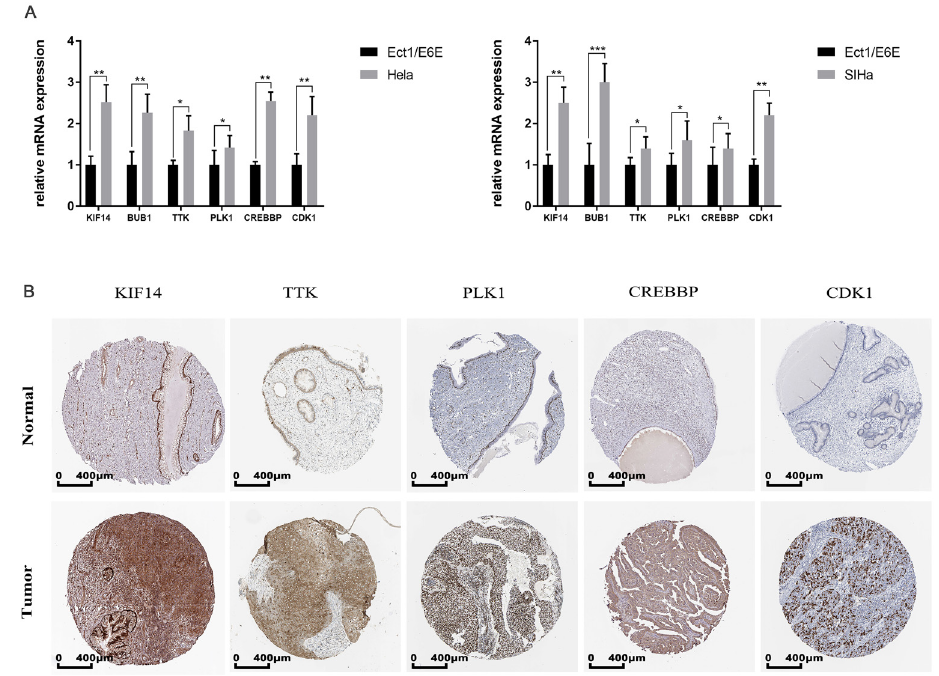
Figure 7. Kinesin family member 14 (KIF14) expression and the indexes of cell cycle signaling pathways. A , RT-PCR analysis results are shown of KIF14 and the indexes (BUB1, TTK, PLK1, CREBBP, and CDK1) of the cell cycle signaling pathways in human cervical cancer cells (HeLa and SIHa) and a normal cervical epithelial cell line (Ect1/E6E). B , The HPA database was utilized to analyze the protein expression of KIF14, TTK, PLK1, CREBBP, and CDK1 in normal and cervical cancer (CC) tissues. Scale bar, 400 m m. Data are reported as means ± SD (n=3). *P o 0.05; **P o 0.01; ***P o 0.001 ( t